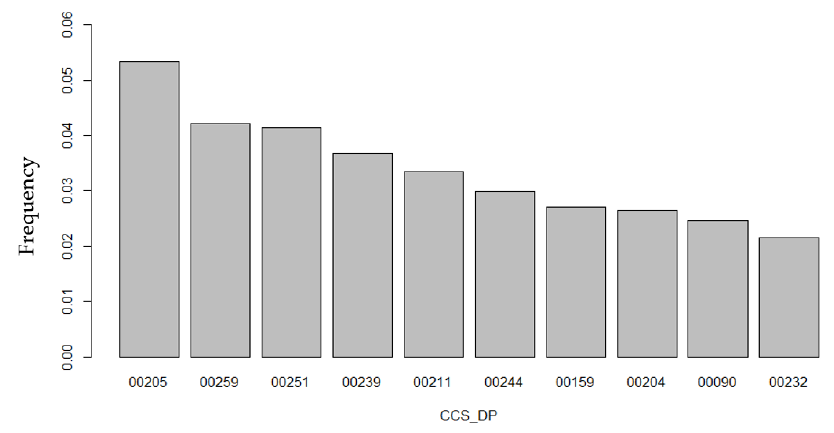
Figure 8. Top 10 symptoms (CCS) in adults.